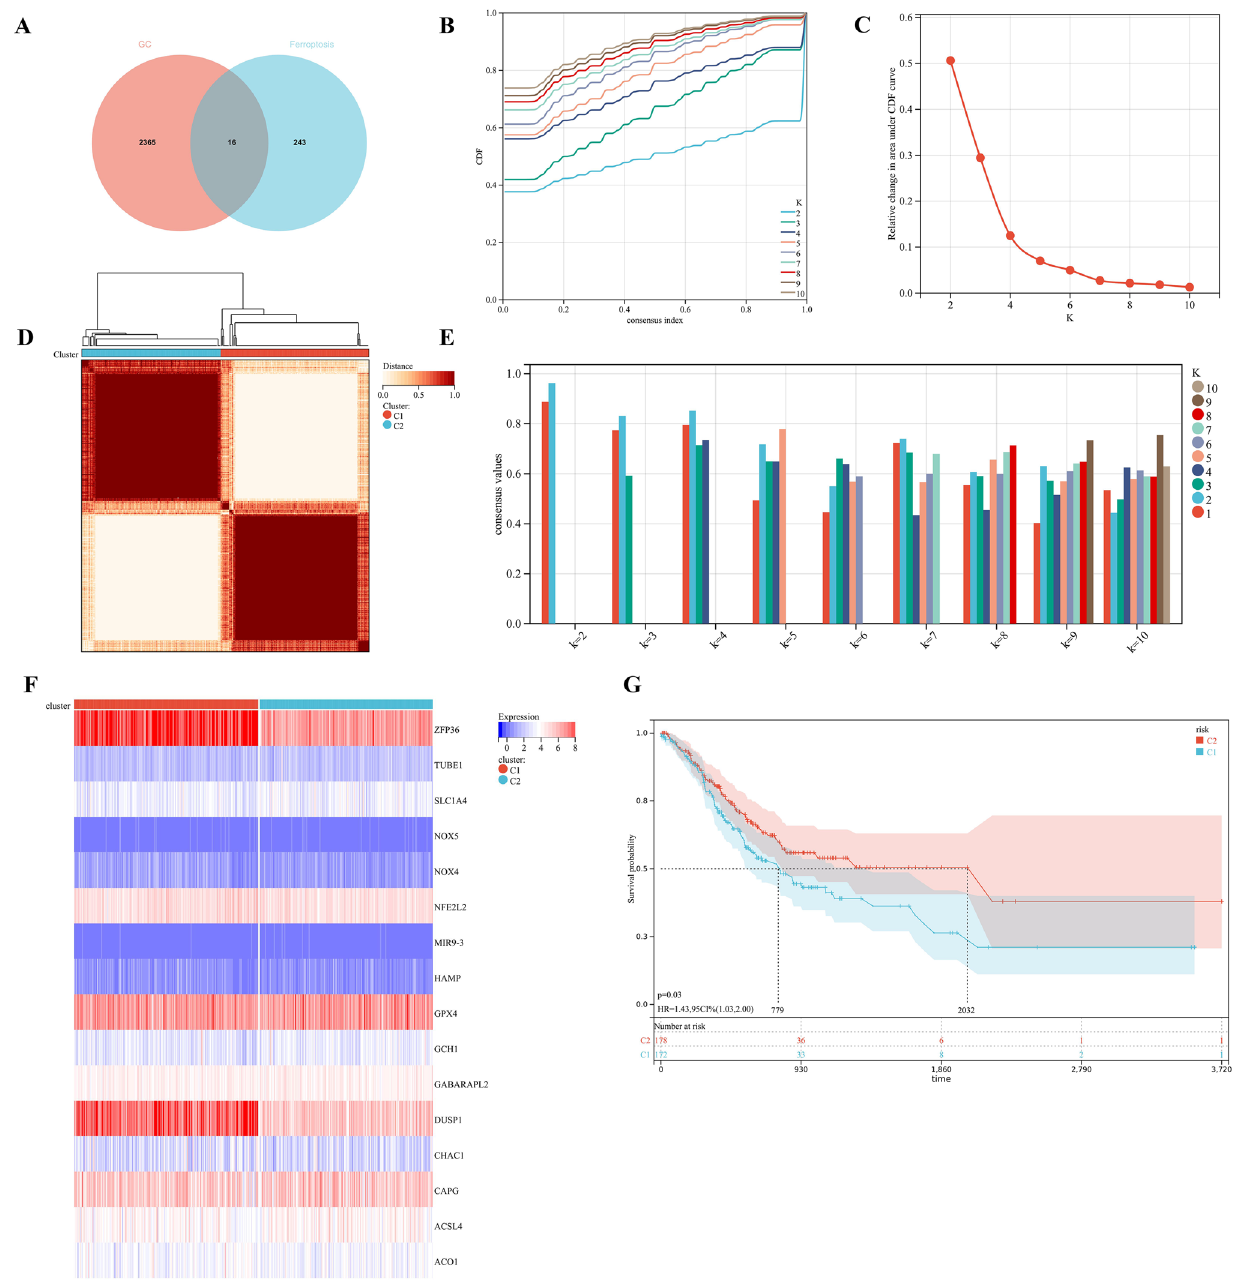
Figure 2. Molecular subtype identification based on FRGs. ( A ) Venn diagram, a prognostic gene for GC associated with ferroptosis. The pink represents GC-related genes, blue represents ferroptosis-related genes. ( B – E ) K = 2 was identified the optimal value for consensus clustering. ( B ) Represents Cumulative distribution curve. ( C ) Represents Area under distribution curve. ( D ) represents Heatmap of consensus clustering. ( E ) Represents Sample clustering consistency. ( F ) Heatmap of FRPGs in two subgroups. ( G ) Kaplan–Meier survival curves for two